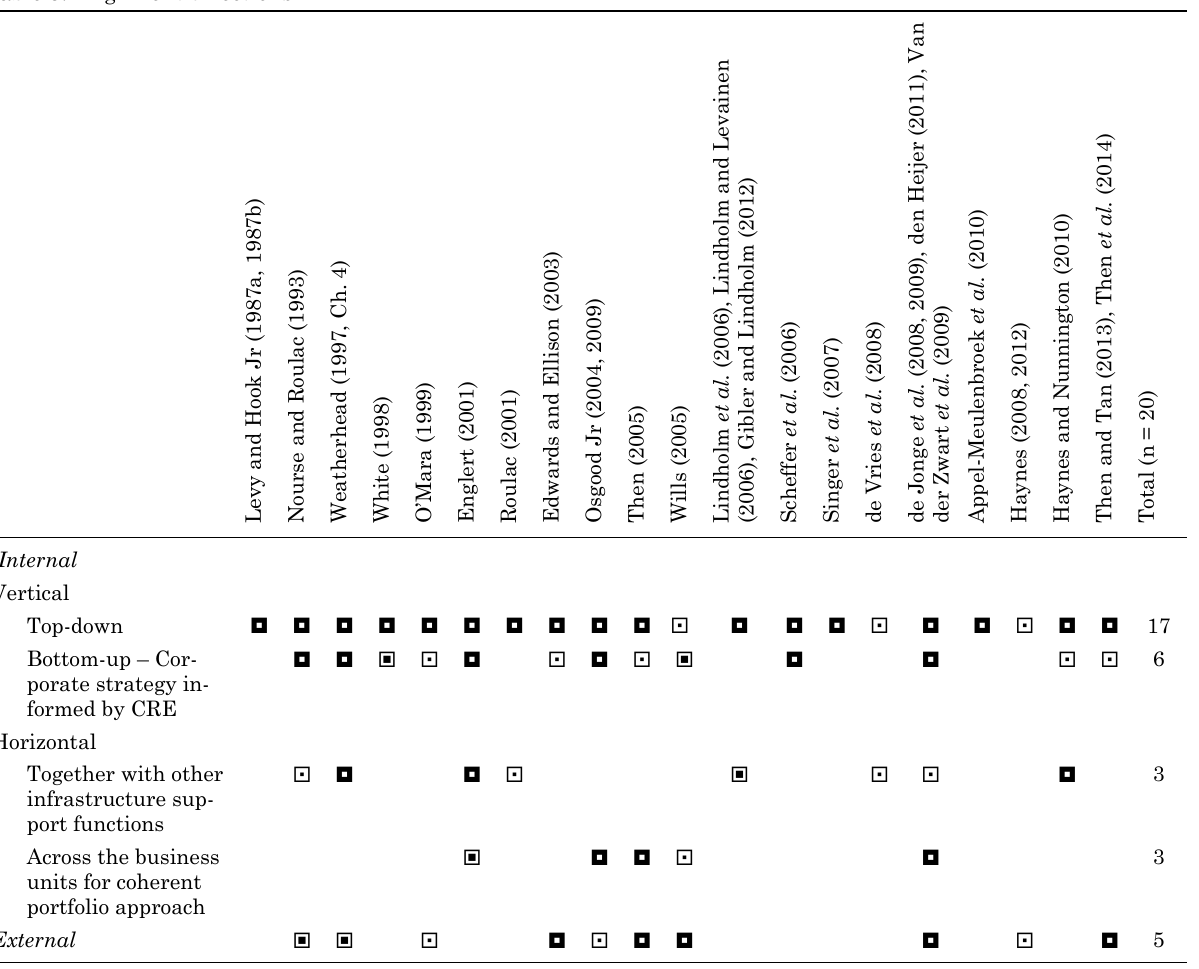
Table 5. Alignment directions